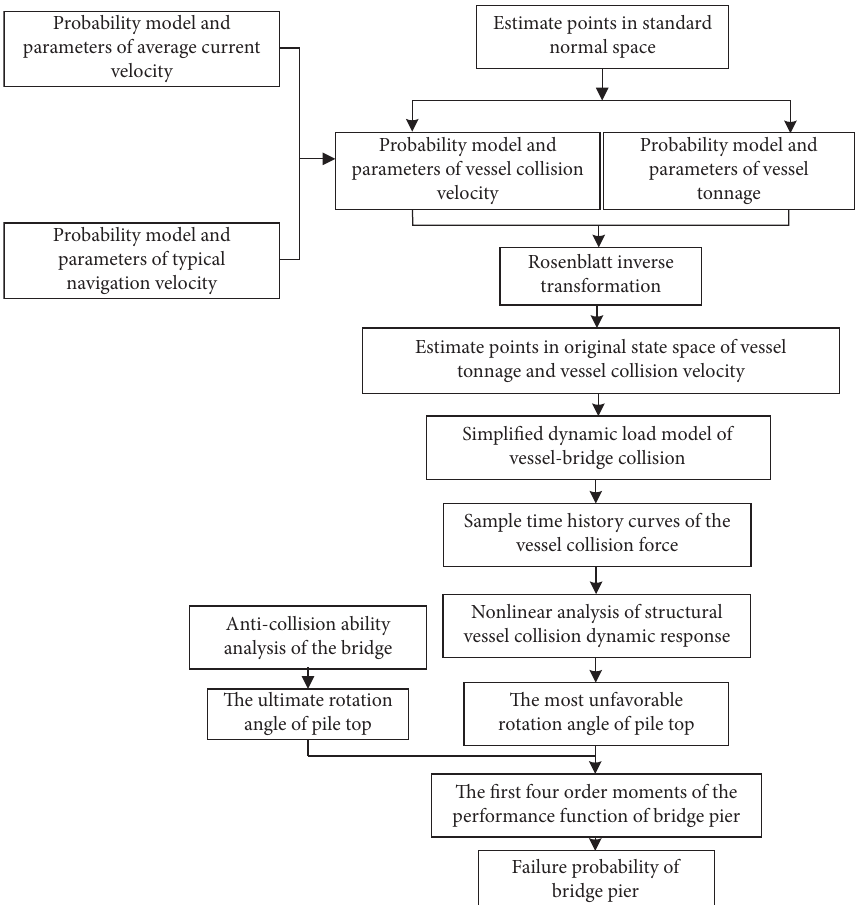
Figure 4: Basic process of vessel collision failure probability analysis for bridge structure.